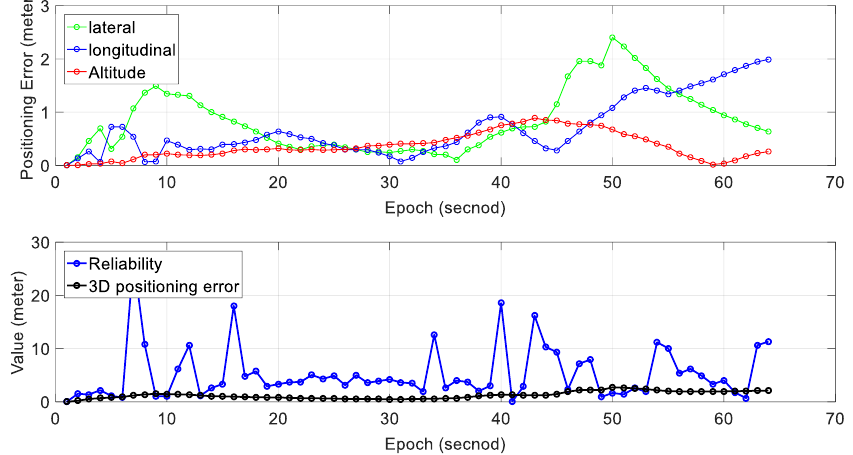
Figure A4. Experiment 6: positioning error and reliability estimation result. The top panel represents the positioning error in lateral, longitudinal and altitude directions separately. The bottom panel represents the estimated reliability and 3D positioning error of SLAM. Table A2. Experiment 4: Performance of NDT-based graph SLAM in a sub-urban area with dense traffic condition.